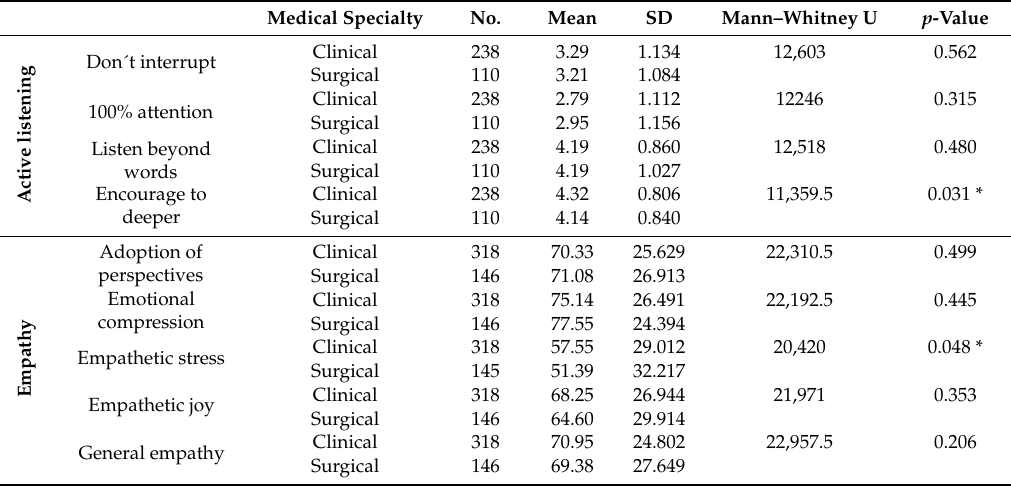
Table 3. Scores in active listening and empathy of students on the basis of specialty